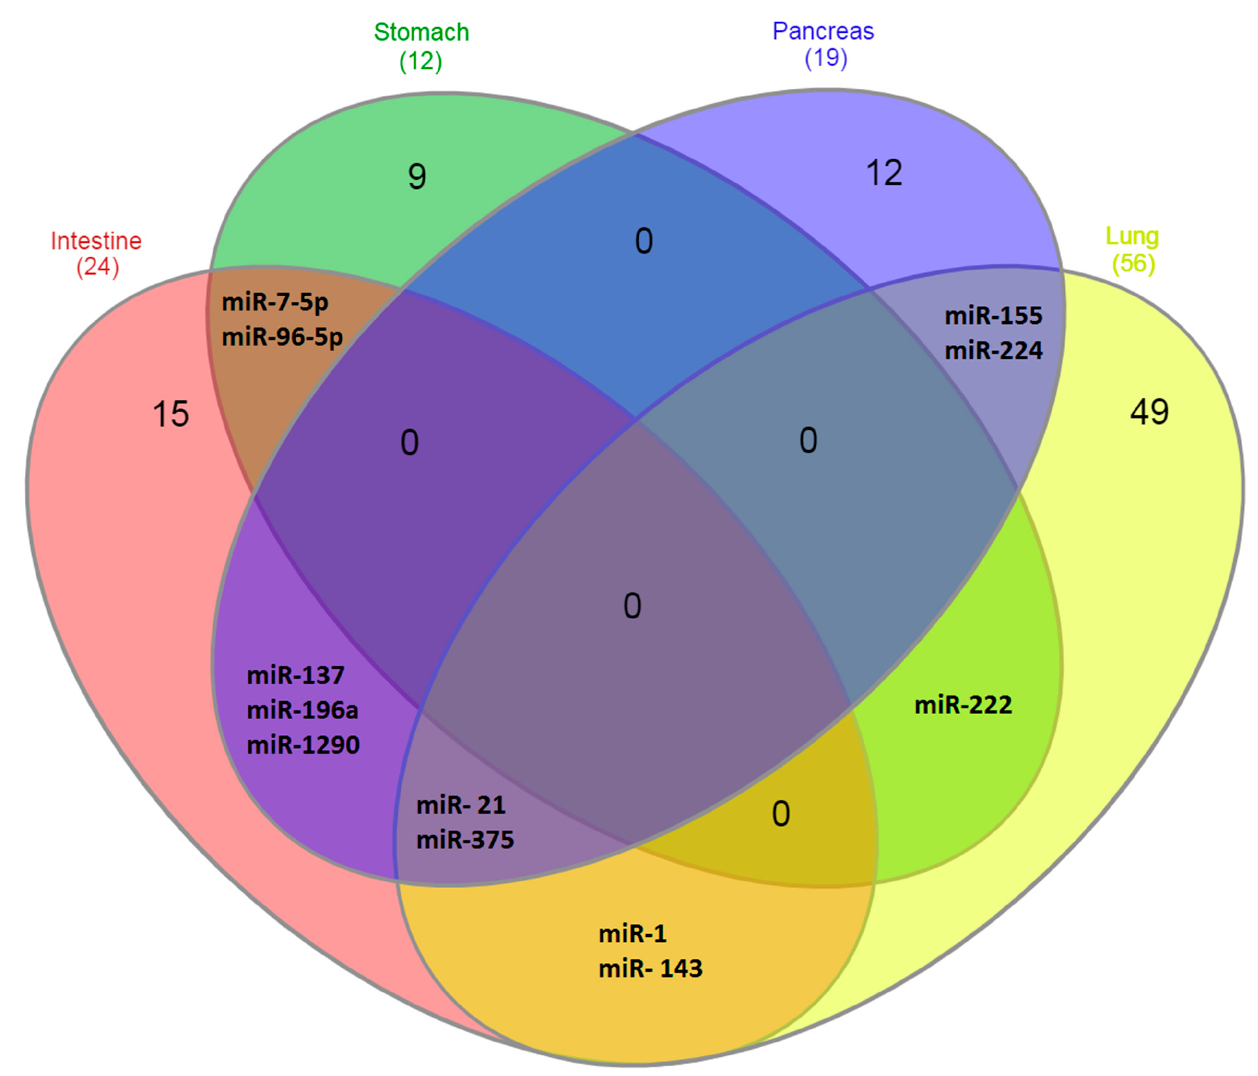
Figure 1. Venn diagrams. Expression of miRNA in NENs of different localizations. At the same time, some miRNAs are differentially expressed in several types of NEN. These include, first of all, miRNA-375 and miRNA-21, which are expressed in NEN tumors of the intestine, pancreas and lung [22,24,25,35]. MiRNA-7-5p and miRNA-96-5p are characteristic of both NENs of the stomach and NENs of the intestine [10,19]. MiRNA-137, miRNA-196a and miRNA-1290 are characteristic of NENs of the intestine and pancreas [8,24,28]; miRNA-1 and miRNA-143 are characteristic of NENs of the intestine and lung [6,21,39,40]; miRNA-222 is characteristics of NENs of the lung and stomach [32] and miRNA-155 and miRNA-224 are characteristic of NENs of the lung and pancreas [35,38,47]. It should be noted that the largest number of miRNAs expressed in more than one type of NEN is expressed in intestinal NENs (75% expressed in different types of NEN), followed by the lung NENs. If the largest amount of miRNA is described for lung NENs, then intestinal NENs do not stand out in this regard, which additionally indicates the reliability of the miRNA expression features identified in this section. At the same time, with the expansion of studies and the identification of additional miRNAs associated with NENs, the numerical characteristics obtained in this